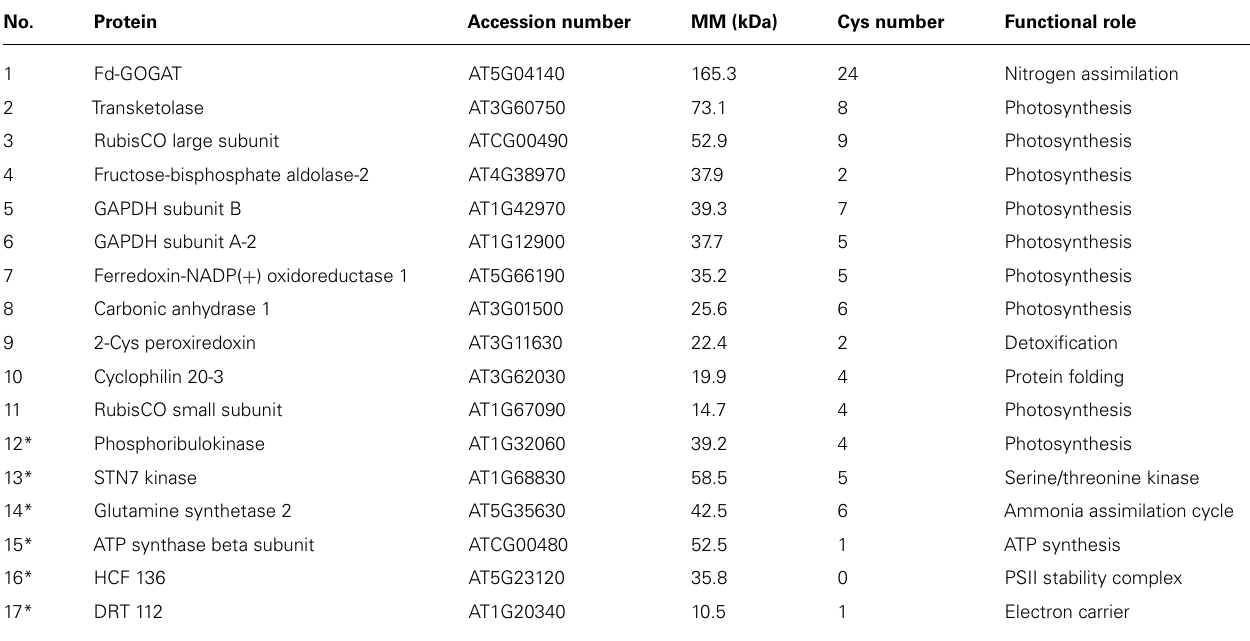
Table 1 | Arabidopsis thaliana stroma proteins containing H 2 O 2 sensitive thiols identified by MALDI-TOF/MS.